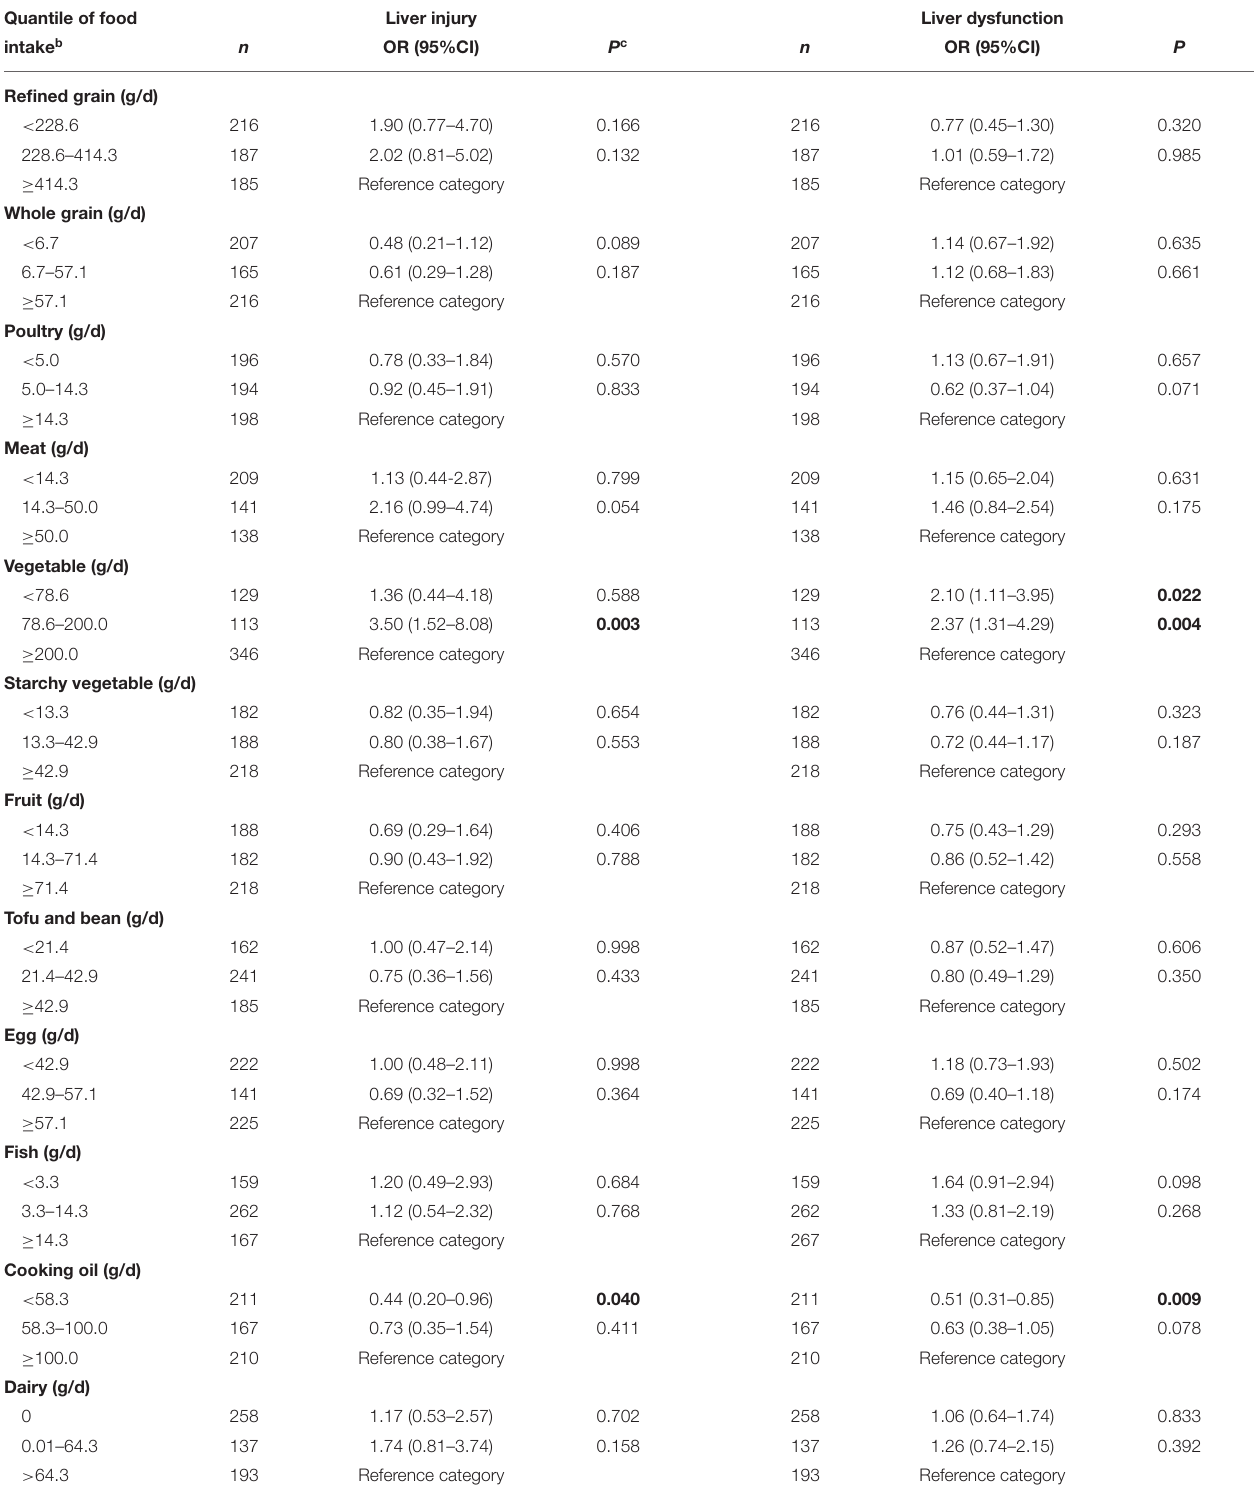
TABLE 3 | Dietary food intake in relation to the risk of liver injury and liver dysfunction during tuberculosis treatment a . Quantile of